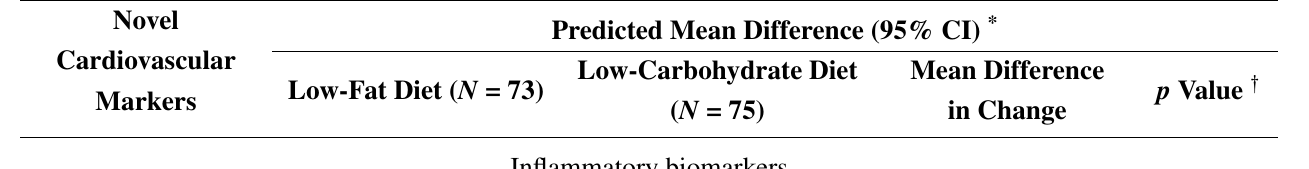
Table A2. Predicted mean difference in changes in novel cardiovascular markers from baseline by assigned dietary group among Caucasians *